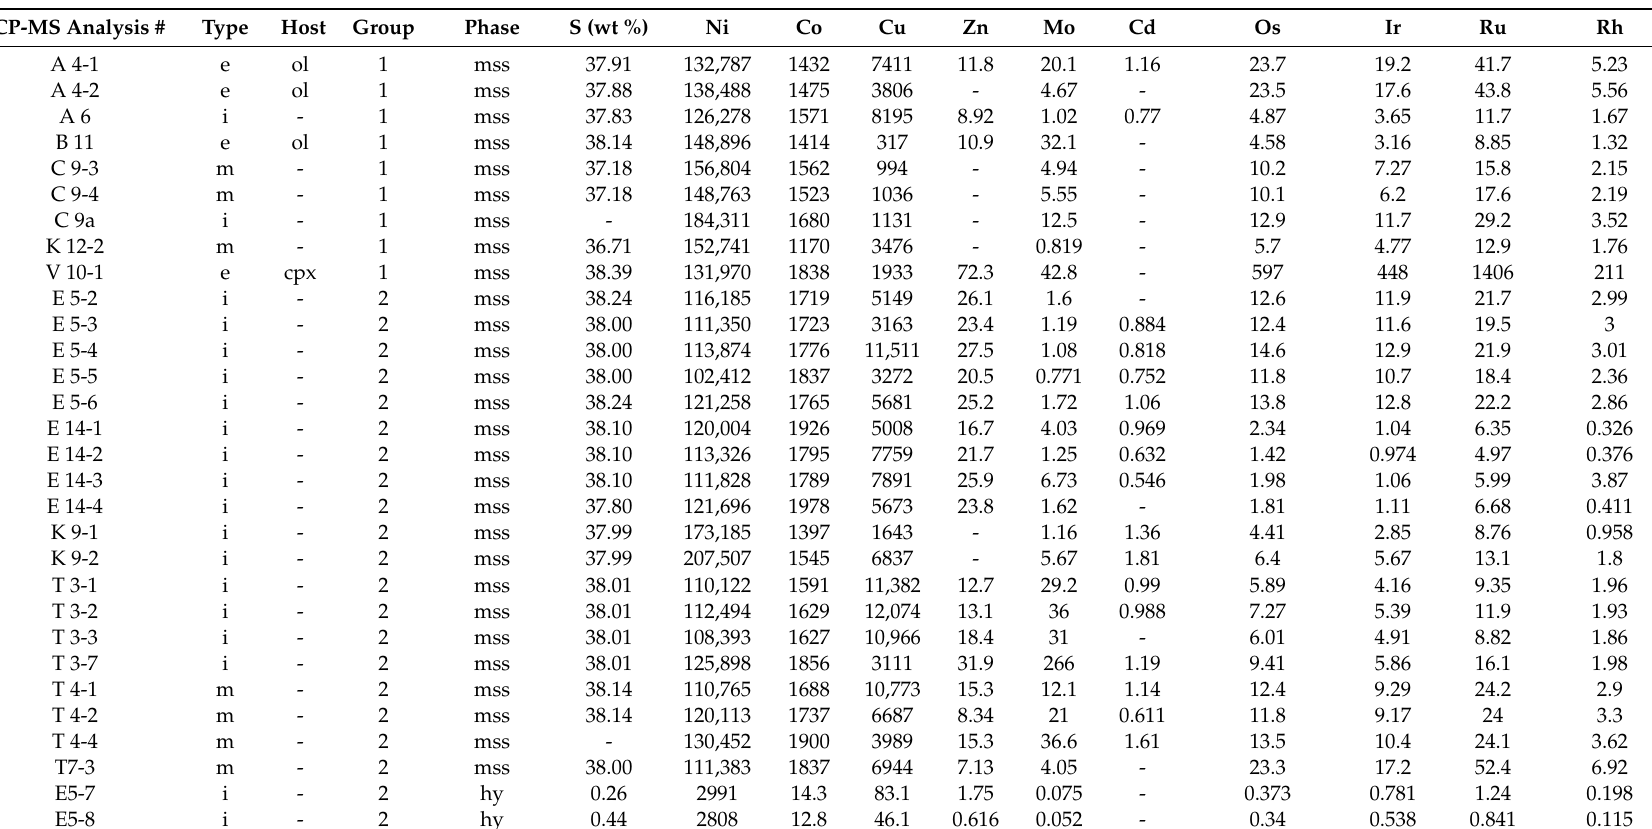
Table 3. LA-ICP-MS abundance data of sulfides and hydroxides from Middle Atlas mantle xenoliths. All abundances are given in parts per million (ppm) except for S (wt %). ICP-MS analysis # denotes the xenolith (capital letter) and sulfide number (first digit), whereas the following digit indicates the number of measurements performed on individual grains. Elemental ratios are normalized to chondrite [40]. Textural occurrence is indicated as e (enclosed), i (interstitial), and m (melt pocket). For the enclosed sulfides, the host silicate is also provided. The platinum-group element (PGE) patterns are 1 (residual PGE pattern, Pt N > Pd N ), 2 (residual PGE pattern, Pt N < Pd N ), 3 (unfractionated PGE pattern), 4 (melt-like PGE pattern), and 5 (incomplete PGE inventory). Abbreviations for phase names are ol